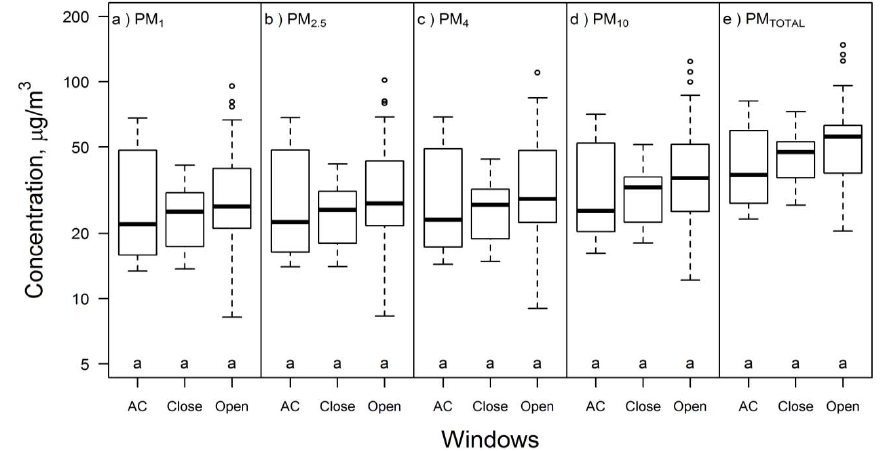
Figure 5. Boxplots of PM mass concentration ( µ g/m 3 ) in Building E (both campaigns) for ( a ) PM 1 , ( b ) PM 2.5 ; ( c ) PM 4 ; ( d ) PM 10 ; and ( e ) PM TOTAL based on window opening. Categories are AC on (AC, windows presumably closed, n = 10), windows closed (Close, n = 16), and windows open (Open, n = 25). Different letters within the same box represent statistically significant ( p < 0.05) groups under the Kruskal-Wallis multiple comparisons